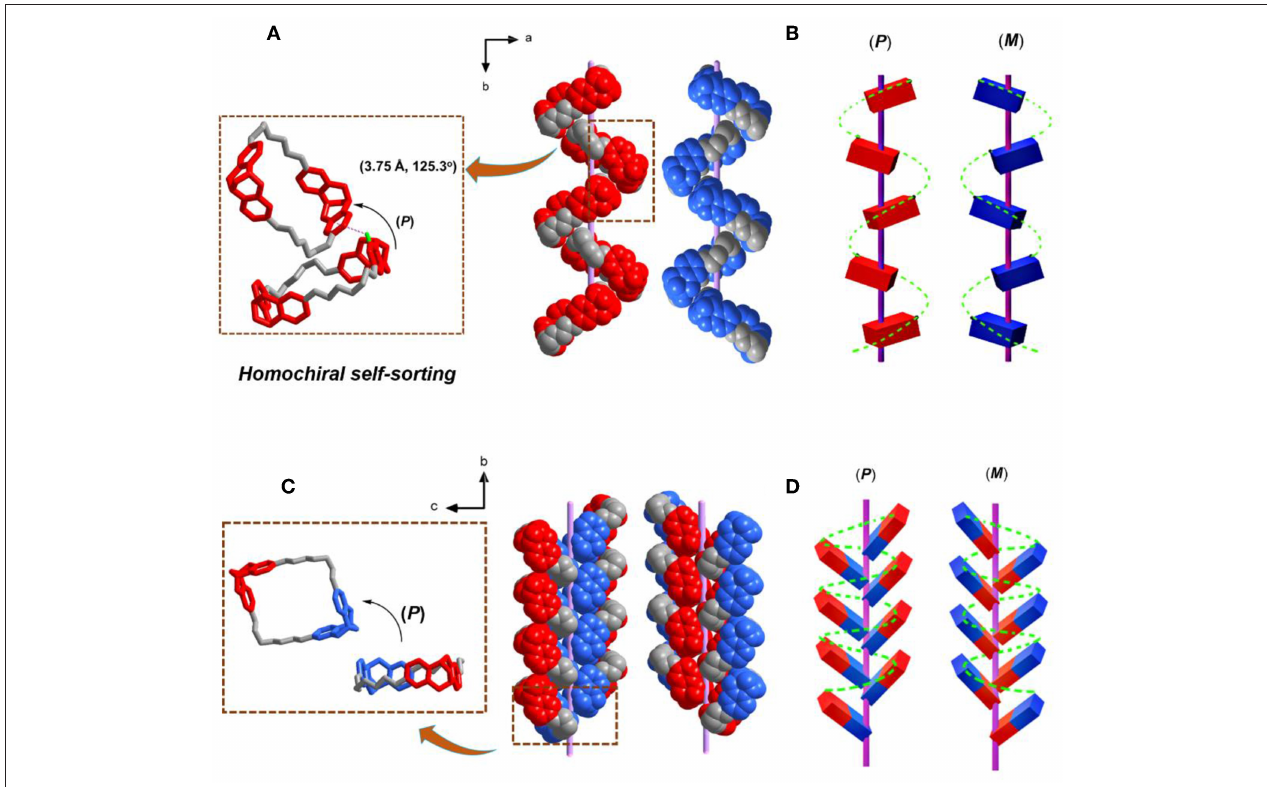
FIGURE 4 | Single-crystal (super)structure of the single helix formed on crystallization of rac -T1 and R 2 N S 2 N -T1 , respectively. (A) Solid-state superstructure of the complementary ( P ) and ( M )-single helixes formed separately from the enantiomeric S 4 N - -T1 and R 4 N -T1 , respectively. (B) The corresponding single helixes of S 4 N -T1 are depicted in red, while the corresponding single helixes of R 4 N -T1 are shown in blue. (C) Solid-state superstructure of the complementary ( P ) and M -single helixes formed separately from the enantiomeric R 2 N S 2 N -T1 , (D) the corresponding single helixes of R 2 N S 2 N -T1 . Note: TB units with S N S N is depicted in red, while TB units with R N R N is shown in blue. For clarity, the solvent molecules inside were also omitted.